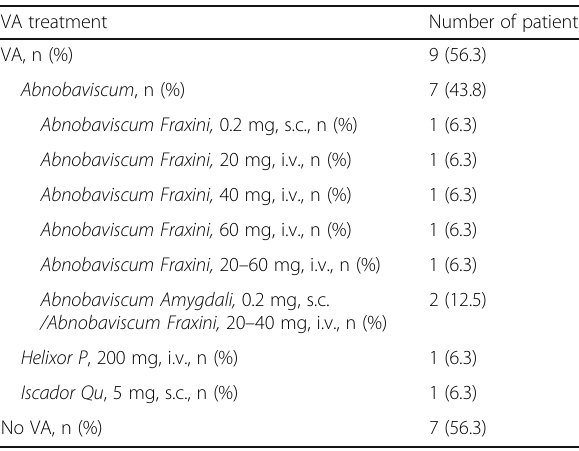
Table 2 Dosage and application form of concomitant VA treatment during ICM